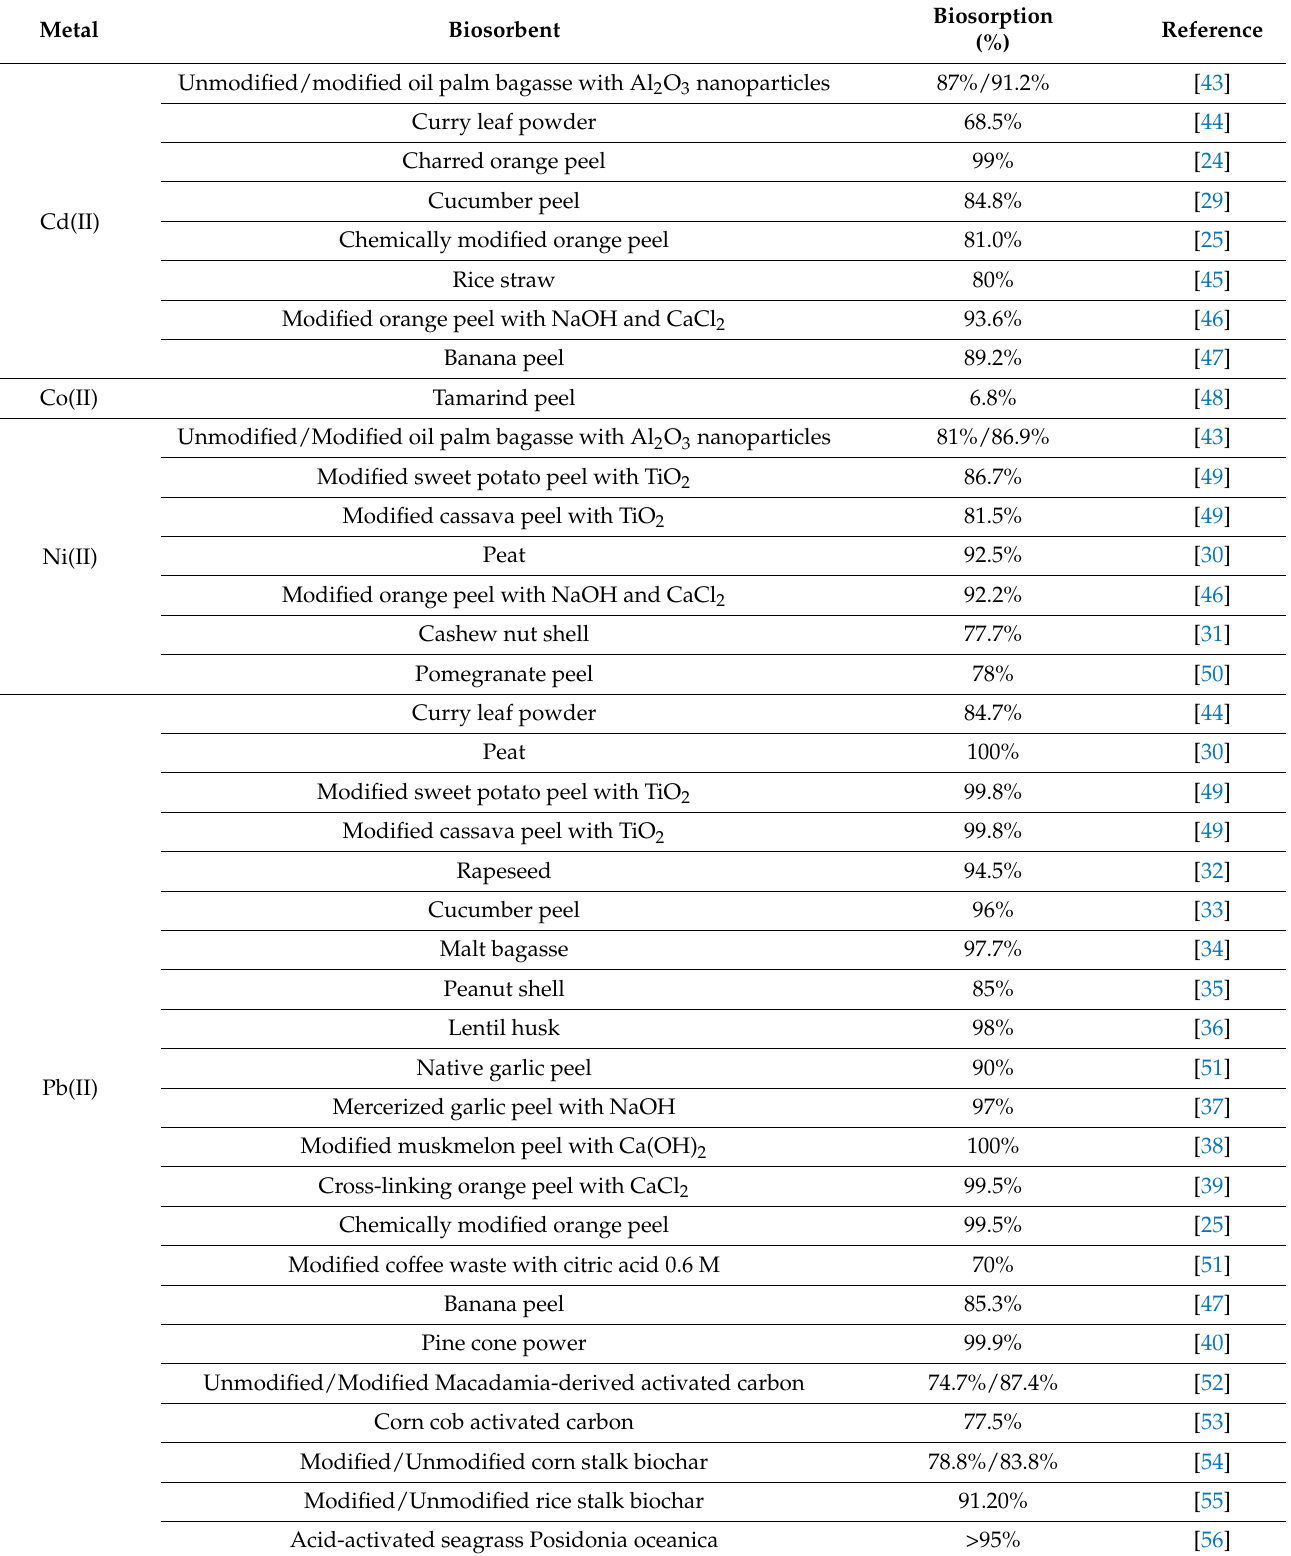
Table 3. Literature review of biosorption percentages of Cd(II), Co(II), Ni(II) and Pb(II) using di-fferent